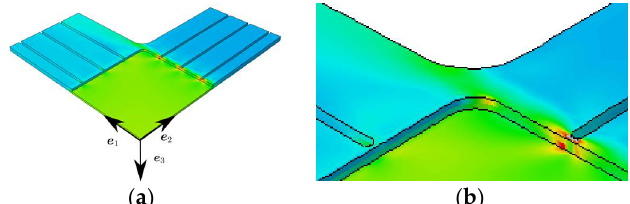
Figure 3. ( a ) FE results for uniaxial load in (cid:2187) (cid:2869) -direction at a displacement of the specimen arms of 0.2 mm, largest principal strain (cid:2013) (cid:2869) ( b ) Detail from ( a ).